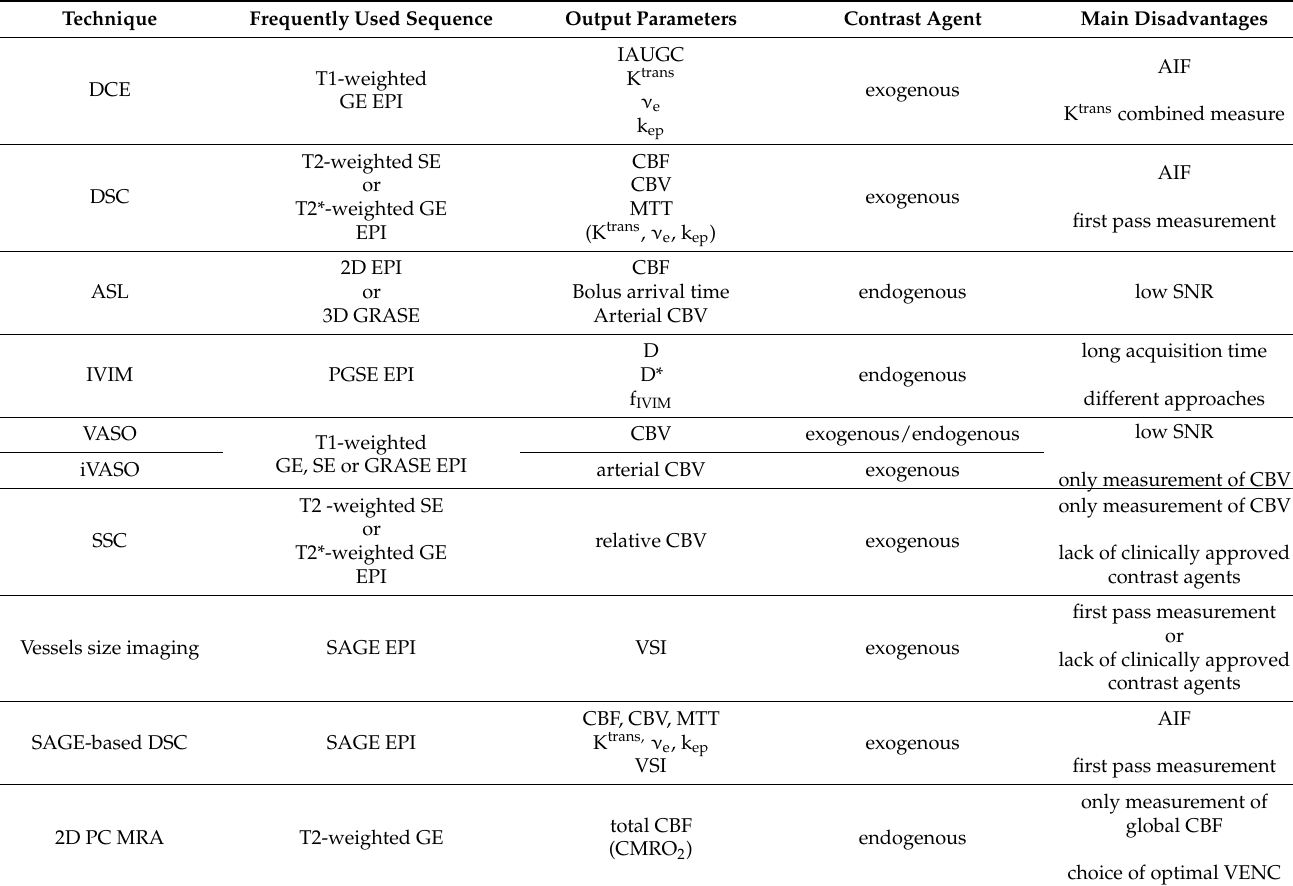
Figure 1. Schematic representation of the two-compartmental pharmacokinetic (PK) Tofts model comprising an intra- vascular compartment (left) and extravascular -extracellular space (EES) compartment (right). The volume transfer between the two compartments is depicted by the transfer constant between the blood plasma and the EES (K trans ) and the transfer constant between the EES and blood plasma (k ep ), respectively. k ep can be calculated using k ep = K trans / ν e , whith ν e volume of the EES per unit volume of tissue. Table 2. Summary of the different output parameters obtained by the different MRI techniques discussed in this